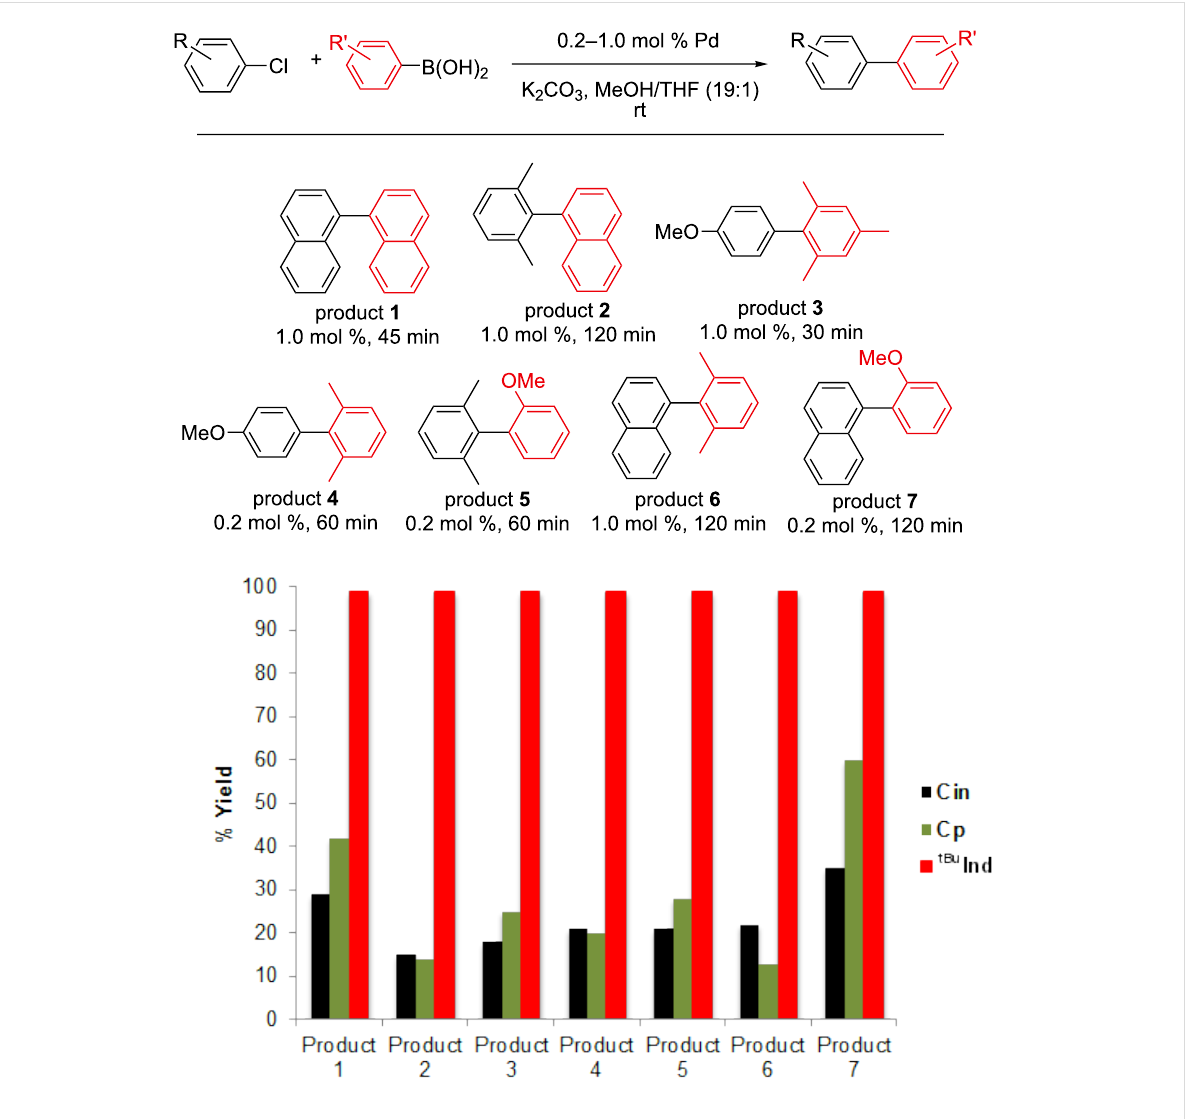
Figure 3: Comparison of catalytic performance of Cin , Cp and tBu Ind for a series of Suzuki–Miyaura reactions using K 2 CO 3 as the base. Yields for Cin and tBu Ind are from previous literature results [15]. All yields were determined using GC and are the average of two